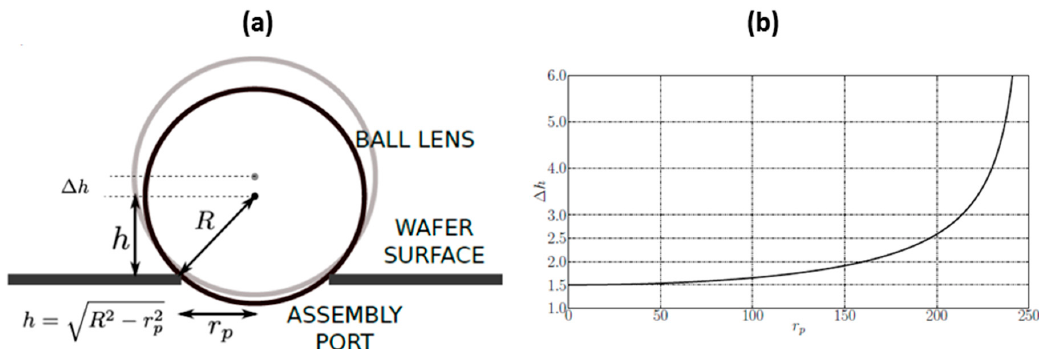
Figure 19. Assembly of ball microlens: ( a ) positioning of the ball microlens (2 R = 500 µ m) into a circular assembly port of radius r p ; and, ( b ) error in axial positioning of the microlens strongly depends on assembly port size (plot of error assuming microlens radius deviation as 1.5 µ m and port diameter error of 1.0 µ m).